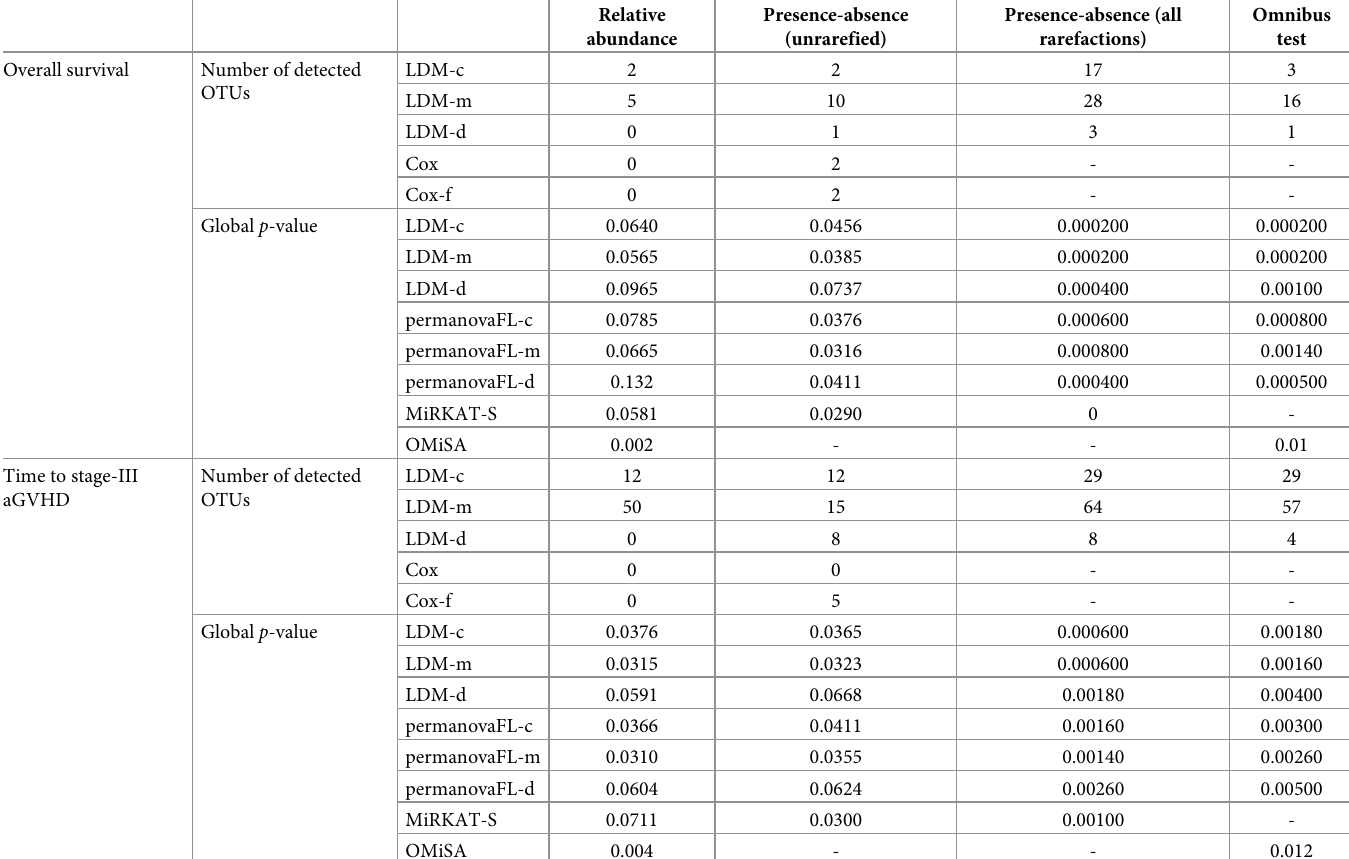
Table 2. Results in analysis of the aGVHD